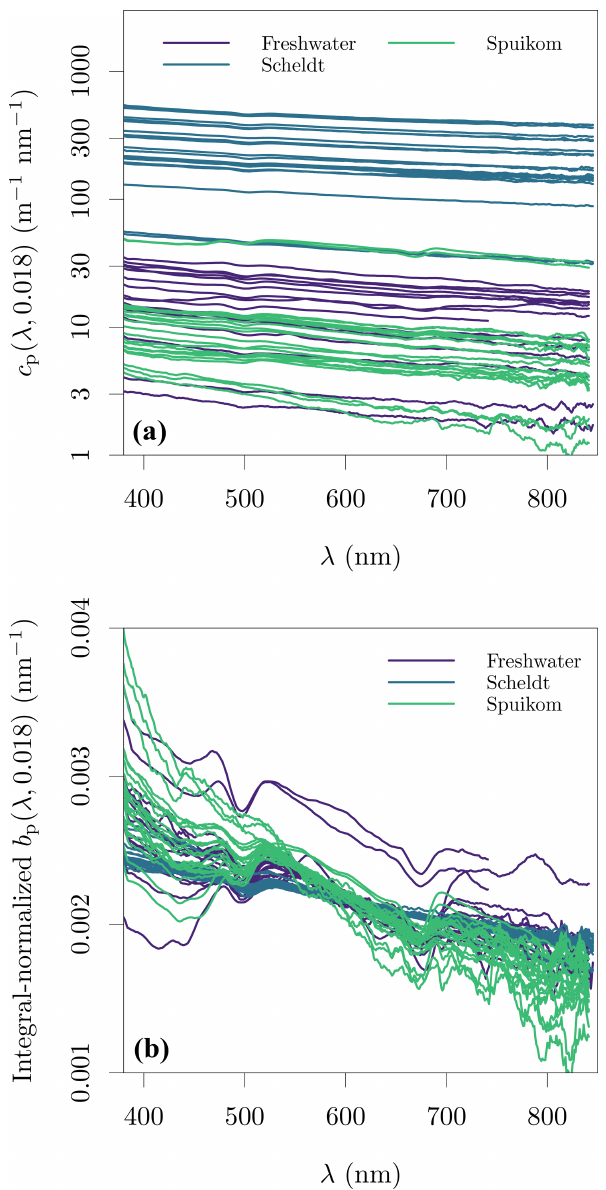
Figure 7. LISST-equivalent (acceptance angle of 0.018 ◦ ) spec- tral particle beam attenuation coefficient, c p (a) , and integral- normalised particle scattering coefficient, b p (b) .